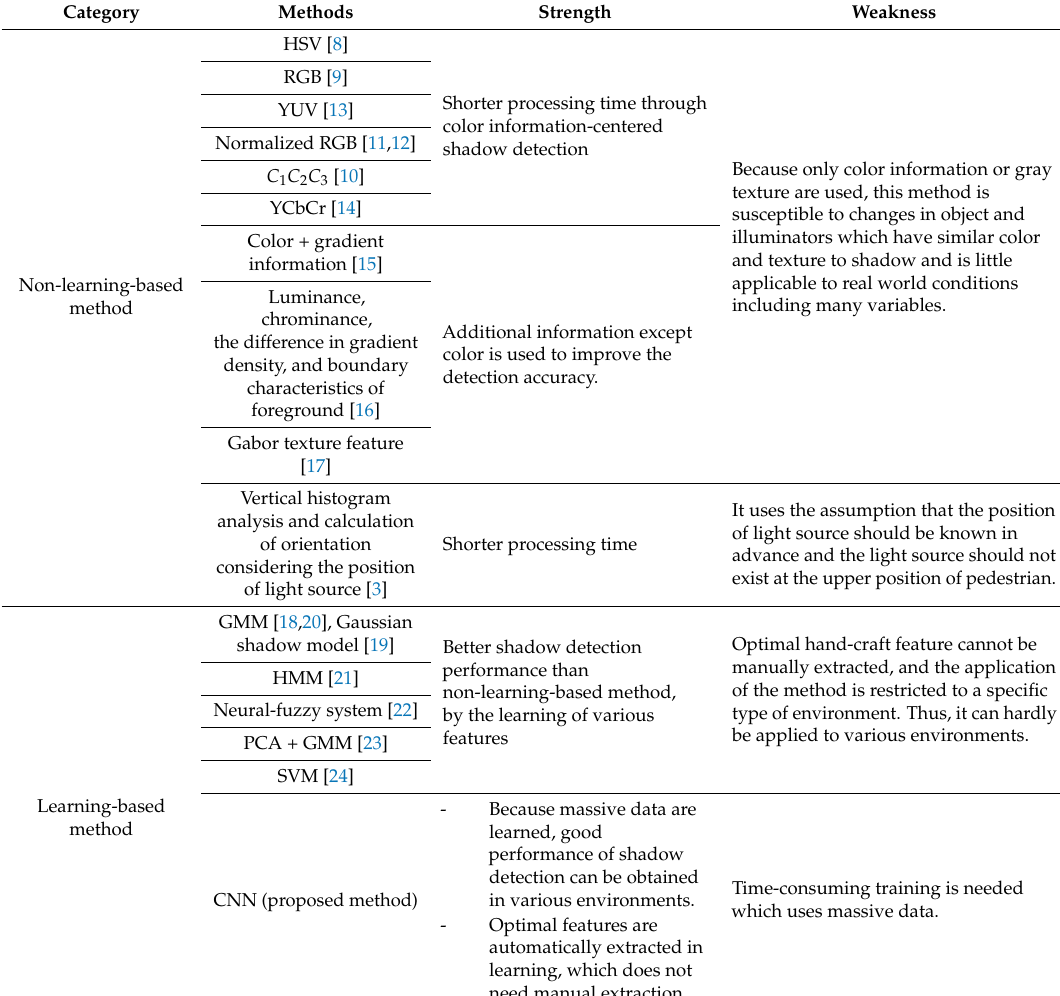
Table 1. Comparisons of previous and proposed research on shadow